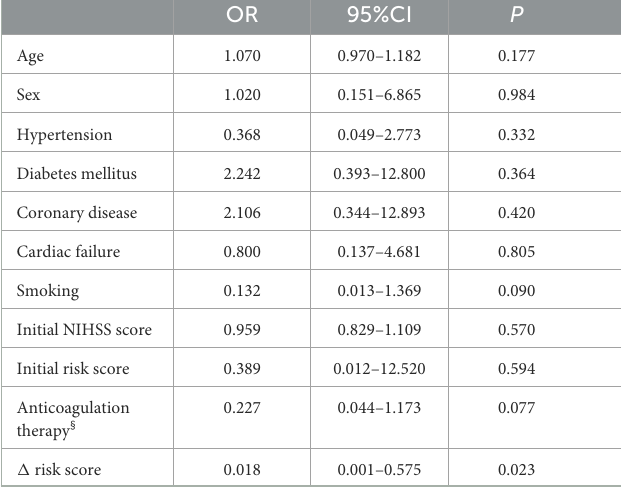
TABLE 3 Logistics analysis for the association of clinical features with the interval of recurrence of CCE. OR 95%CI